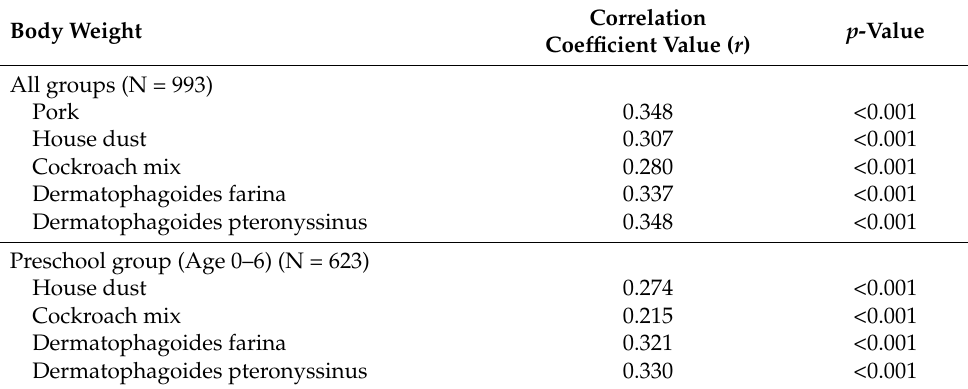
Table 4. The associations between body weight and allergen-specific